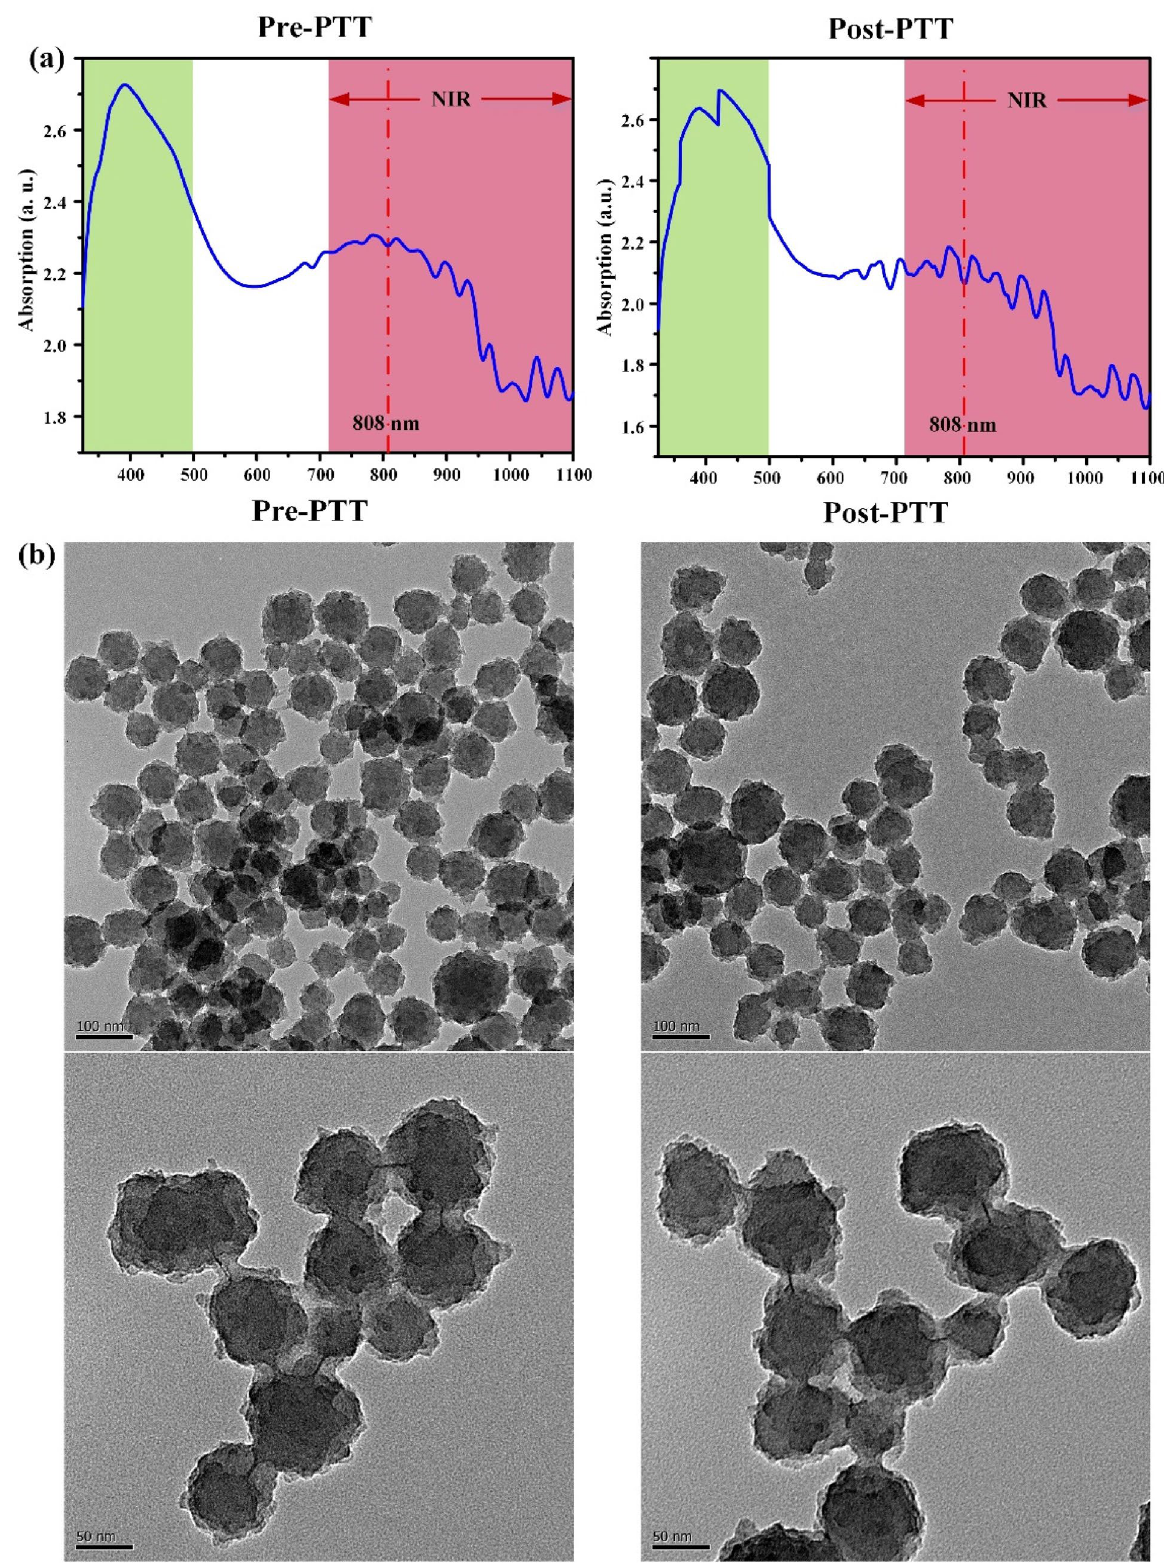
Figure 3. Characterization of IR-CS–PPy NCs ( a ) UV–Vis spectrum of IR-CS–PPy NCs (125 μg/mL) before and after PTT. ( b ) FE-TEM images of IR-CS–PPy NCs (125 μg/mL) before and after